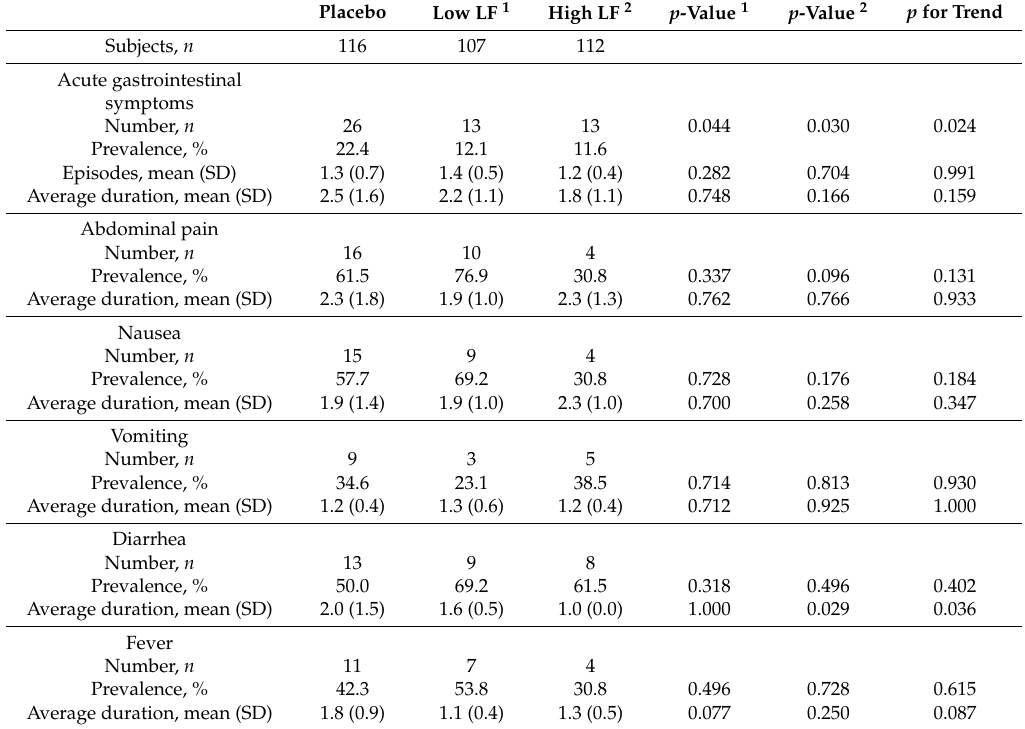
Table 2. Prevalence, episodes, and average duration of acute gastrointestinal